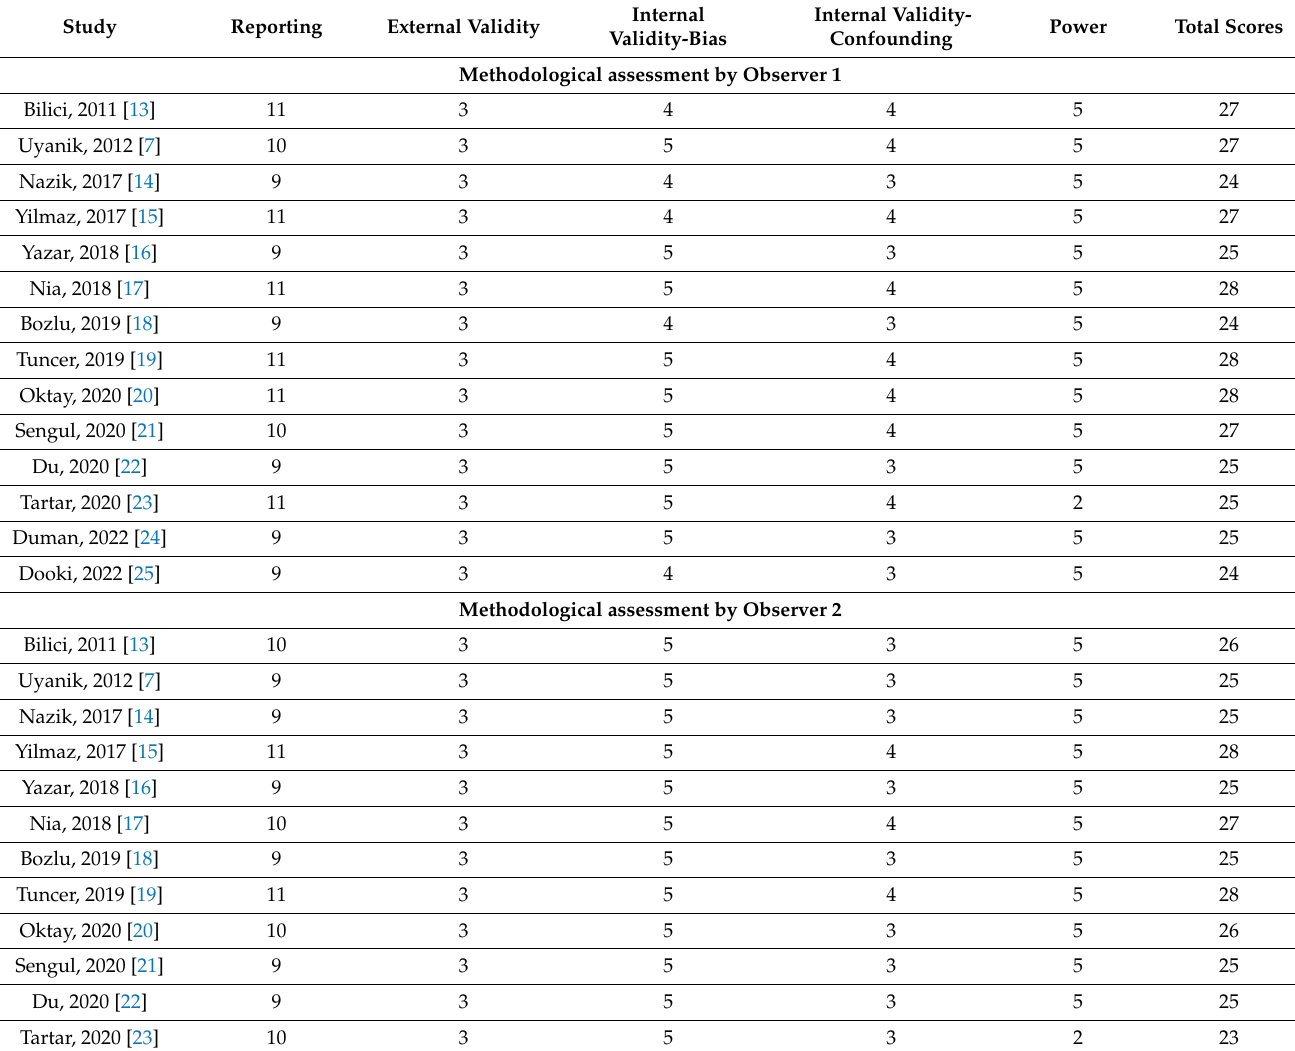
Table 2. Methodological assessment for the included studies by Observer 1 and Observer